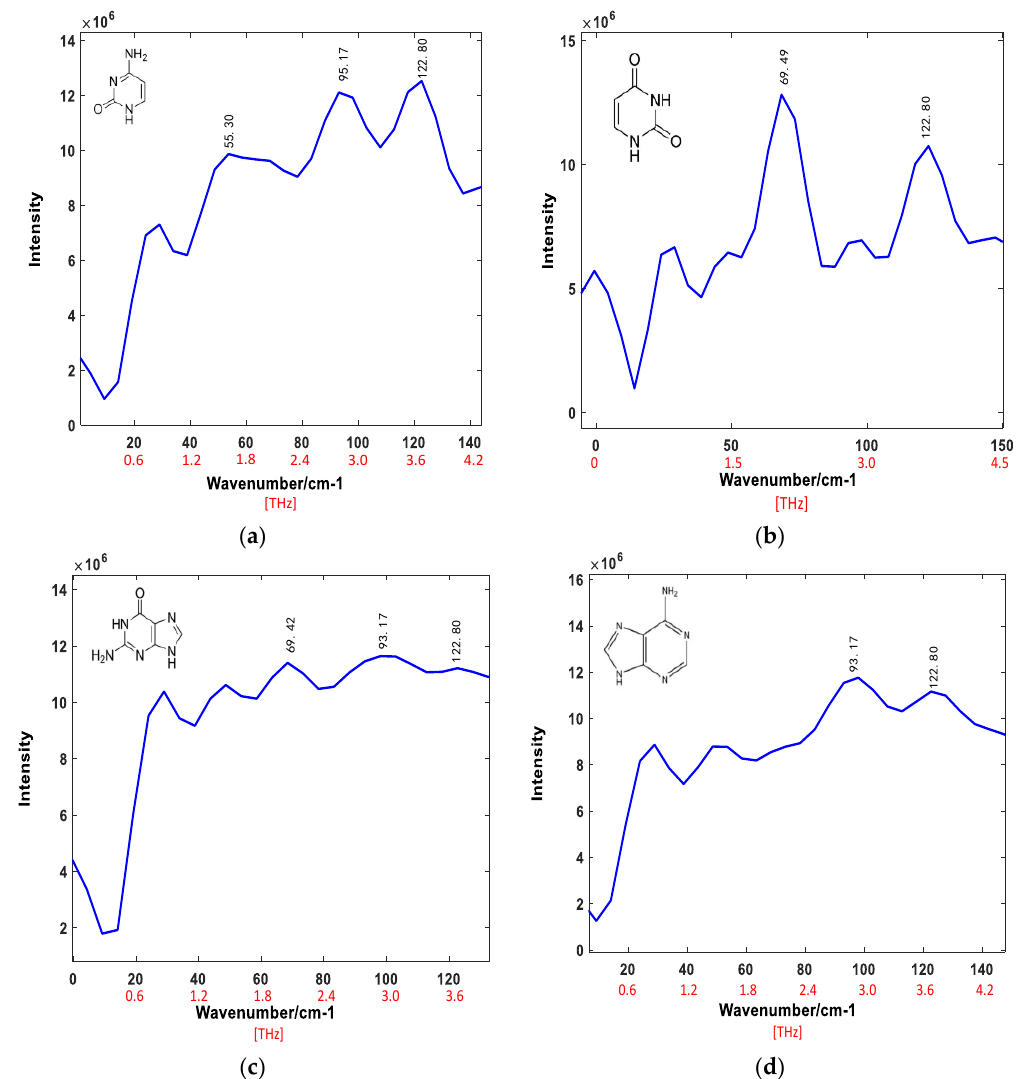
Figure 8. THz Raman spectra of four nucleobases: ( a ) cytosine, ( b ) uracil, ( c ) guanine, ( d ) and adenine.